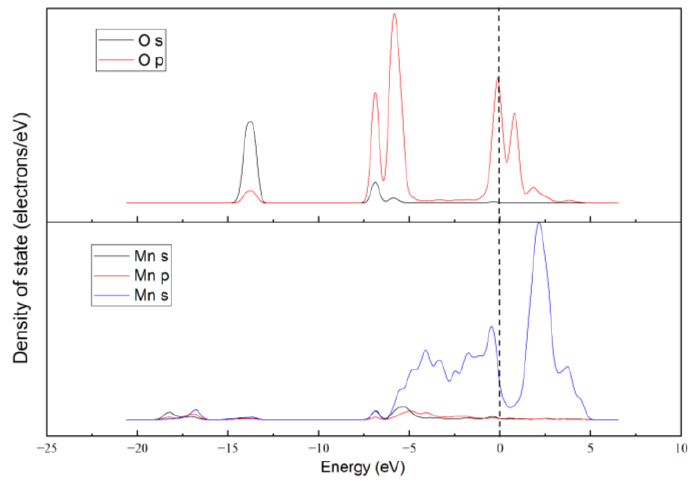
Figure 7. The partial density of state of O 2 adsorption configuration.